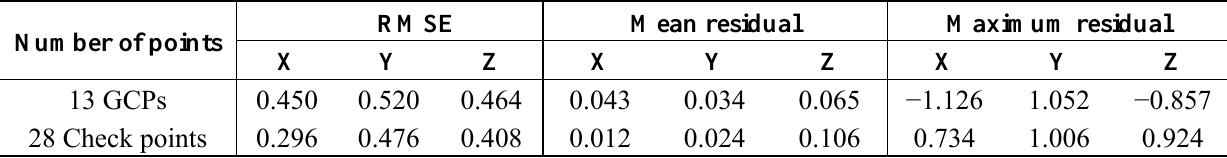
Table 5. Error statistics of bundle adjustment of Henan province test field (Unit: m).